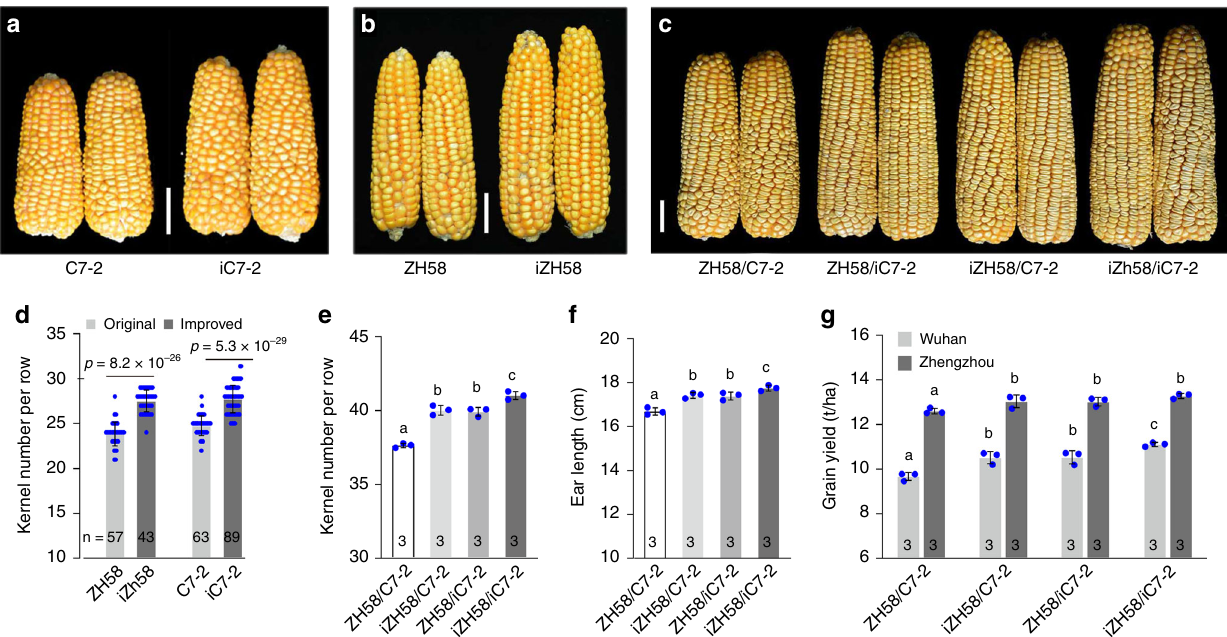
Fig. 5 Genetic effect of KNR6 Haplotype2 on maize grain yield. a Ears of inbred line Chang7-2 and its improved line Chang7-2 qKNR6 . b Ears of the inbred line Zheng58 and its improved line Zheng58 qKNR6 . c Ears of hybrids Zheng58 × Chang7-2, Zheng58 × Chang7-2 qKNR6 , Zheng58 qKNR6 × Chang7-2, and Zheng58 qKNR6 × Chang7-2 qKNR6 . d Kernel number per row in the original and improved lines. Both Zheng58 and Chang7-2 were improved by introducing the qKNR6 desirable allele using marker-assisted backcrossing. The values are means ± s.d.; p value is estimated by the one-way ANOVA. e – g Phenotypic evaluation of KNR ( e ), EL ( f ), and grain yield ( g ) in hybrids carrying one or two desirable alleles. Phenotypic evaluations of the original hybrid Zheng58/ Chang7-2 and improved hybrid Zheng58 qKNR6 /Chang7-2 qKNR6 , were performed at Wuhan (30.60°N, 114.30°E) and Zhengzhou (ZZ, 34.75°N, 113.62°E) in 2017 spring with randomized block design, respectively. Different letters in ( e , f , g ) at the top of each column indicate a signi fi cant difference at p < 0.05 determined by the Tukey HSD test. n is the number of ears examined in ( d ) and the number of blocks in ( e , f , g ). C7-2, Chang7-2; iC7-2, improved line Chang7-2 qKNR6 ; ZH58, Zheng58; iZH58, improved line Zheng58 qKNR6 . Scale bars = 2 cm in ( a – c ). Source data underlying Fig. 5d – g are provided in a Source Data fi